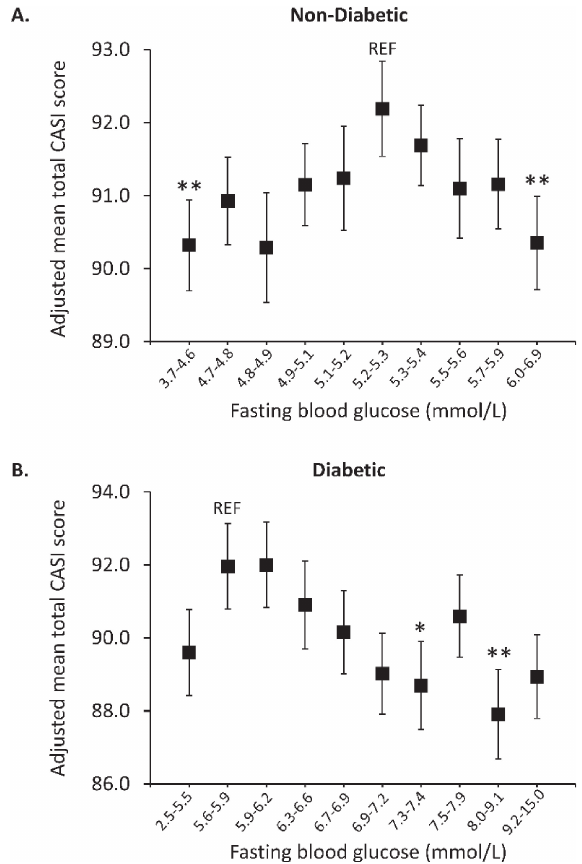
Figure 1. Adjusted mean total CASI scores by deciles of glucose in A) non-diabetic and B) diabetic men. Data presented are means with standard errors (error bars). Means were adjusted for age, total years of education, and (for diabetics only) diabetic medication. Mean CASI scores between glucose deciles were calculated and compared using analysis of covariance. CASI, Cognitive Ability Screening Instrument; REF, reference group. * P = 0.05, ** P < 0.05